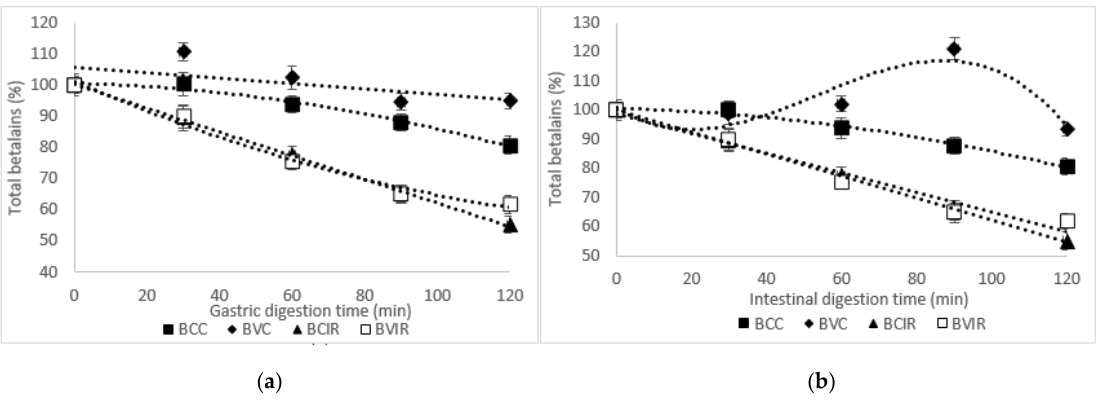
Figure 1. The in vitro digestion of total betalains in powders samples in gastric simulated juice ( a ) and intestinal simulated juice ( b ): BV C , BC C —red beet purée dried by convection method; BV IR , BC IR —red beet purée dried by infra-red (IR) method.